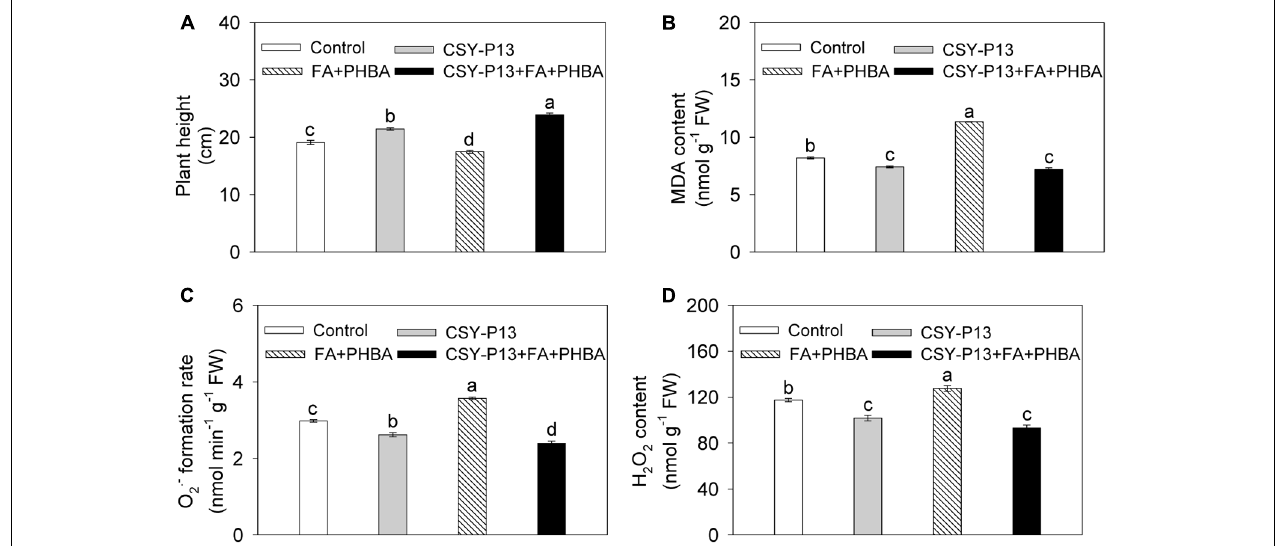
FIGURE 4 | Effects of CSY-P13 and the mixture of FA and PHBA on plant height (A) , and levels of MDA (B) , O •− 2 (C) , and H 2 O 2 (D) in cucumber leaves. Bars represent standard errors of three biological replicates. Values with the different letters are significantly different at P < 0.05 by LSD test using SPSS for Windows 22.0 software (IBM Corp., Armonk, NY, United